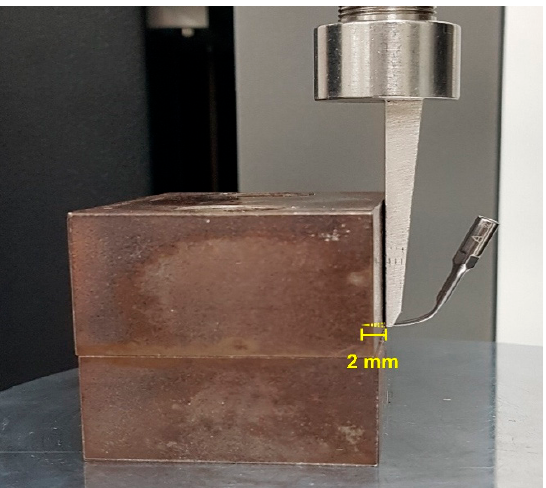
Figure 2. Image of the metal block holding the stainless-steel ultrasonic scaler tip firmly in place and the metal block contact surface parallel to the jig.